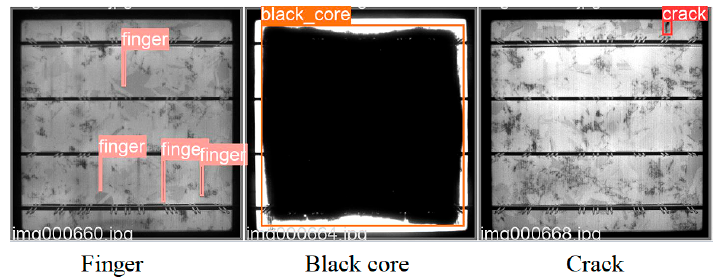
Figure 1. The three most common types of PV cell damage.